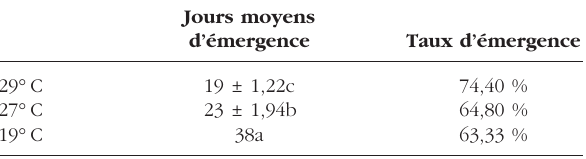
Tableau III. – Délais moyens d’émergence de C. f. strongylus en fonc- tion de la température.